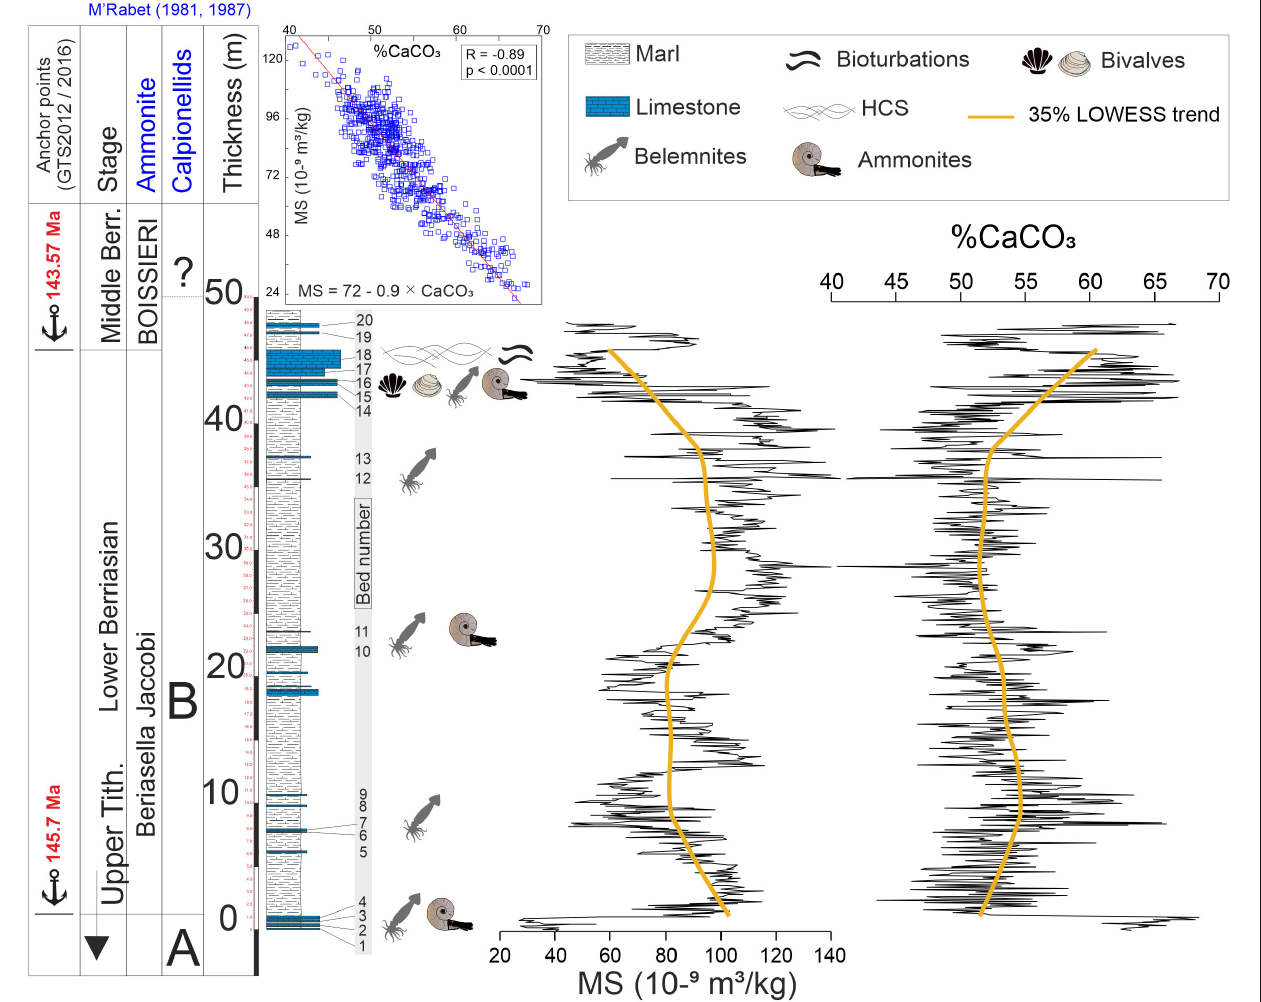
FIGURE 3 | Variations of the used proxies through the studied interval with a 35%LOWESS detrend (thick yellow line). The top left graph shows the linear model of the MS vs. % CaCO 3 ; R = −